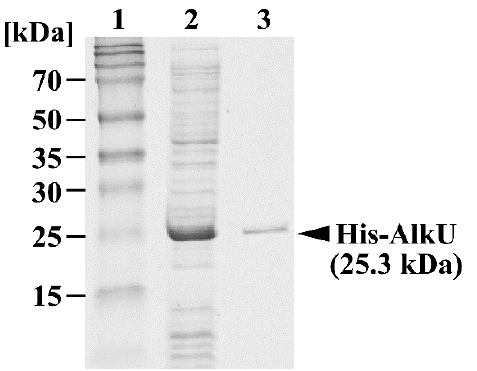
Figure 6. SDS-PAGE analysis of protein fraction. Lanes: 1, molecular-weight markers; 2, Crude cell extract of E. coli BL21 (DE3) harboring pETALKU (10 µ g of protein); 3, Elution fraction including His-AlkU (2 µ g of protein).